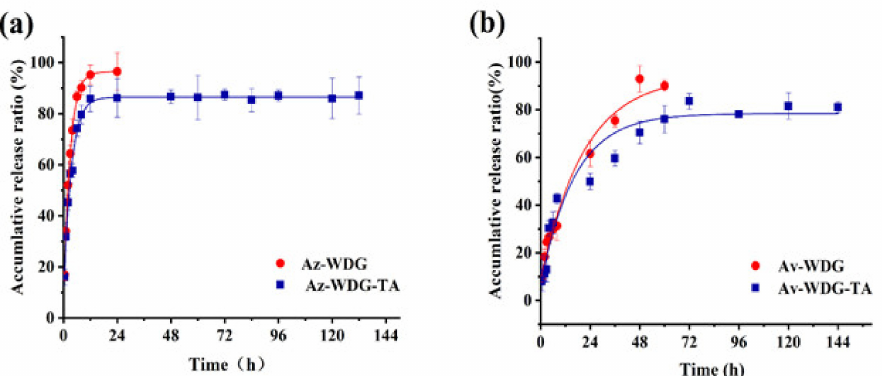
Figure3. Sustainedreleaseprofilesof( a )Az-WDGandAz-WDG-TAand( b